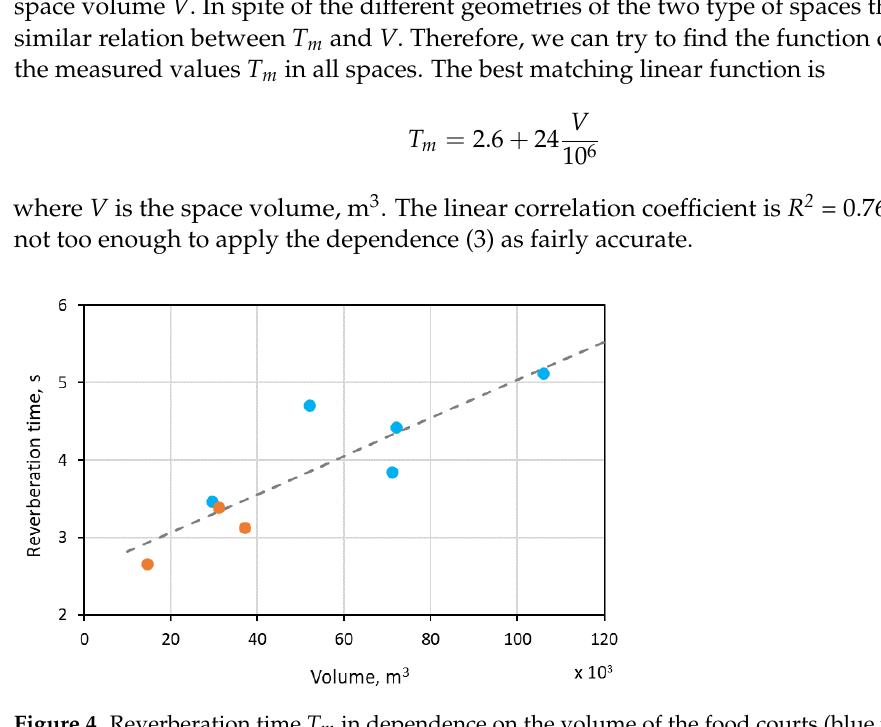
Figure 4. Reverberation time T m in dependence on the volume of the food courts (blue points) and galleries (red points). Dotted line shows the linear approximation (3) of this dependance.